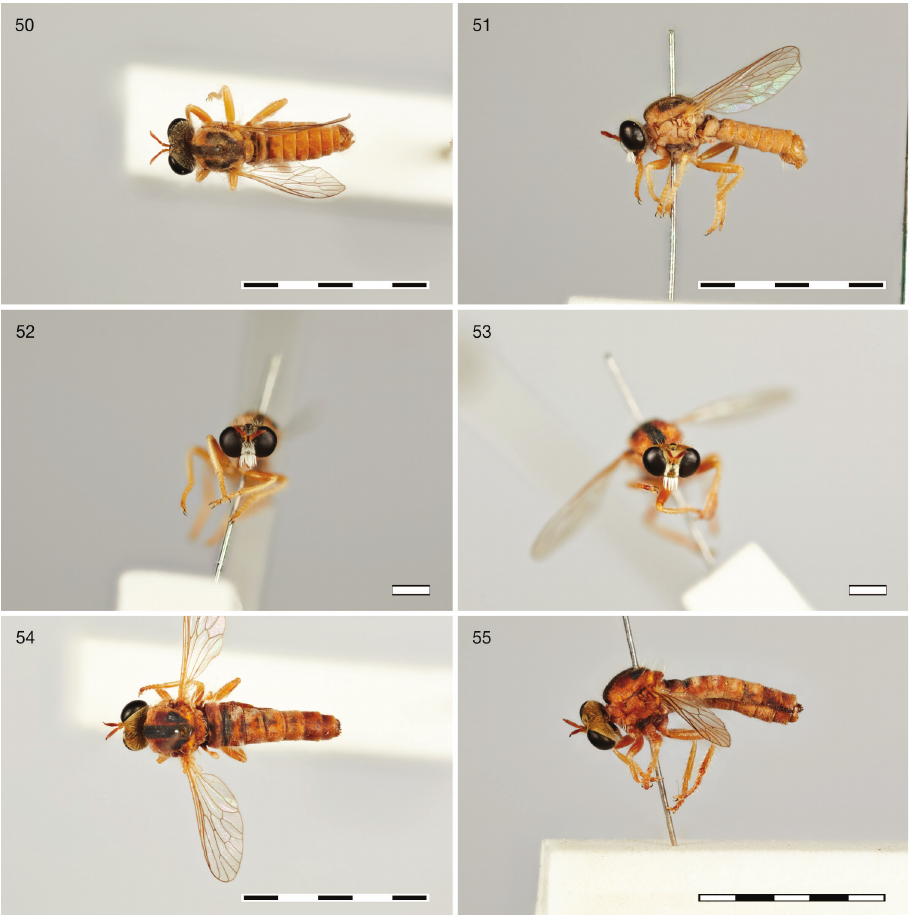
Figures 50–55. Microphontes whittingtoni : 50 ♂ Holotype (NMSA-DIP-4777), dorsal (Morphbank #861895) 51 same, lateral (#861897) 52 same, head anterior (#861899) 53 ♀ Paratype (NMSA- DIP-74619), head anterior (#861902) 54 same, dorsal (#861904) 55 same, lateral (#861906). Scale bars : 5 mm ( 50–51, 54–55 ), 1 mm ( 52–53 suturally, median posterior scutum (between dc setae) long yellowish setose, setae directed anteriorly; scutellum white pubescent, ds sctl setae present, long yellowish setae, ap sctl setae present, 6–8 long yellowish macrosetose; postmetacoxal area en- tirely membranous. Leg : orange to light brown, apubescent, all setae circular in cross section; pro coxa orange to light brown, white pubescent, white setose and macrosetose; pro femur orange to light brown, short white setose, white macrosetose: 2–3 postero-dorsal dis- tally; pro tibia orange to light brown, short white setose, yellowish macrosetose: 4 in 1 antero-dorsal row, 4 in 1 dorsal row, 4 in 1 posterior row, 4 in 1 postero-ventral row, distal tip with 3–4 long yellowish macrosetae; mes coxa brown, white pubescent,